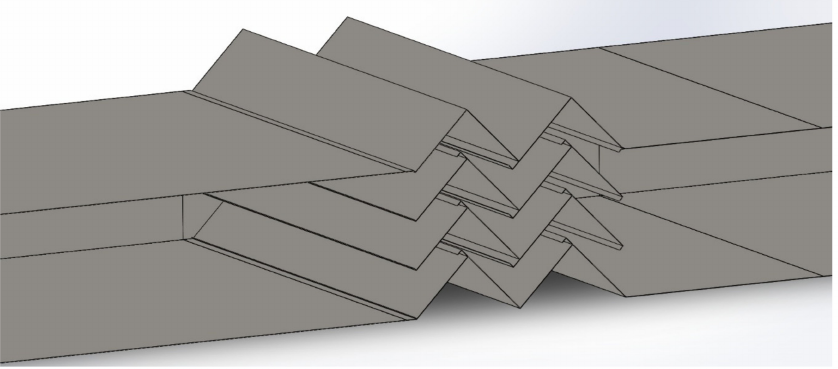
Figure 2. Visualisation of wave-plate mist eliminator with drainage channels (geometry B_10_0).